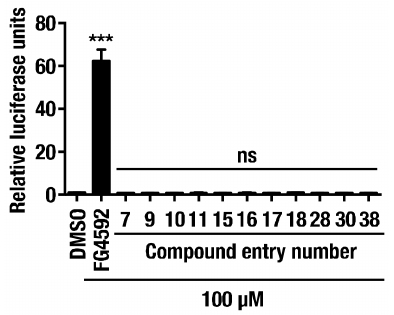
Figure 6. HIF activation using the identified compounds ( 7 , 9 – 11 , 15 – 18 , 28 , 30 , and 38 ) under normoxic conditions. The degree of induction is presented as relative luciferase units, with the value from DMSO treatment of cells set as 1 for each treatment. Experiments were performed in triplicate. Data are means ± SEMs ( n = 3). The statistical significance of the results compared with data from the control group was calculated using one-way ANOVA with Newman-Keuls multiple-comparison tests. ns, p > 0.05; *** p <